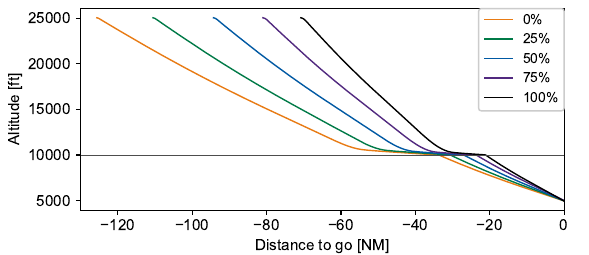
Figure 7. Descent profiles of a B777 aircraft as a function of distance at different speed brake angles (indicated by color). A cruising altitude of 25,000 ft, a speed of Mach 0.75 and below 10,000 ft, 240 kt are calculated. A maximum deceleration path angle of 0.5 ◦ and a payload of 9 t are